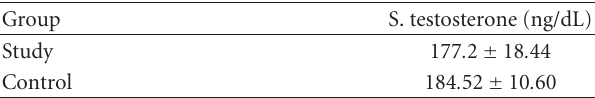
Table 4: Preoperative average testes sizes in study and control groups.